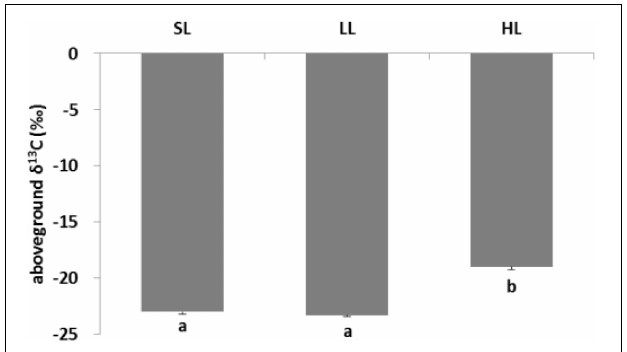
FIGURE 6 | Response of seagrass stable isotope carbon to light treatments. Saturating light: SL, 200 µ mol photons/m 2 /s; low light: LL, 20 µ mol photons/m 2 /s; high light: HL, 600 µ mol photons/m 2 /s. SL and HL were in the optimal light range between the minimum saturating light and the minimum inhibiting light. Different letters on the bars indicate mean values for a particular light condition that significantly differed at ( p < 0.05) (Mean ± SD, n = 3) analyzed by one-way